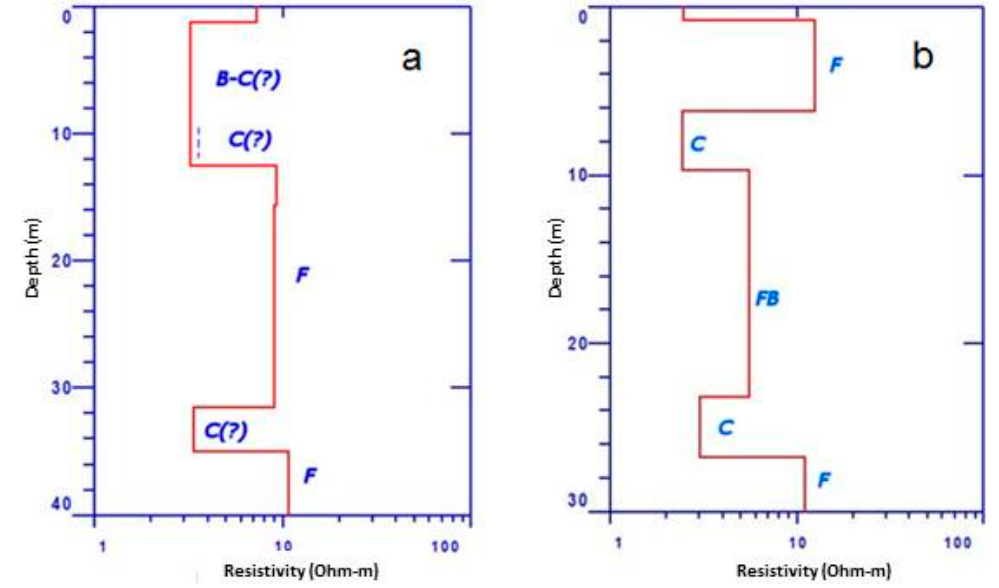
Figure 6. Representative TDEM (Time Domain Electro Magnetic) profiles at the northern site ( a ) and at the southern site ( b ). In the north, high resistivity is observed for both unit B and C (10 Ohm-m), while in the south the middle aquifer (unit B) has low resistivity (5 Ohm-m). The letters along the profile are the interpretation of the resistivity values: F—Fresh, B—Brackish, FB—fresh–brackish, C—Clay unit. Additional TDEM profiles are included in Figure S1 in the Supplementary Material.